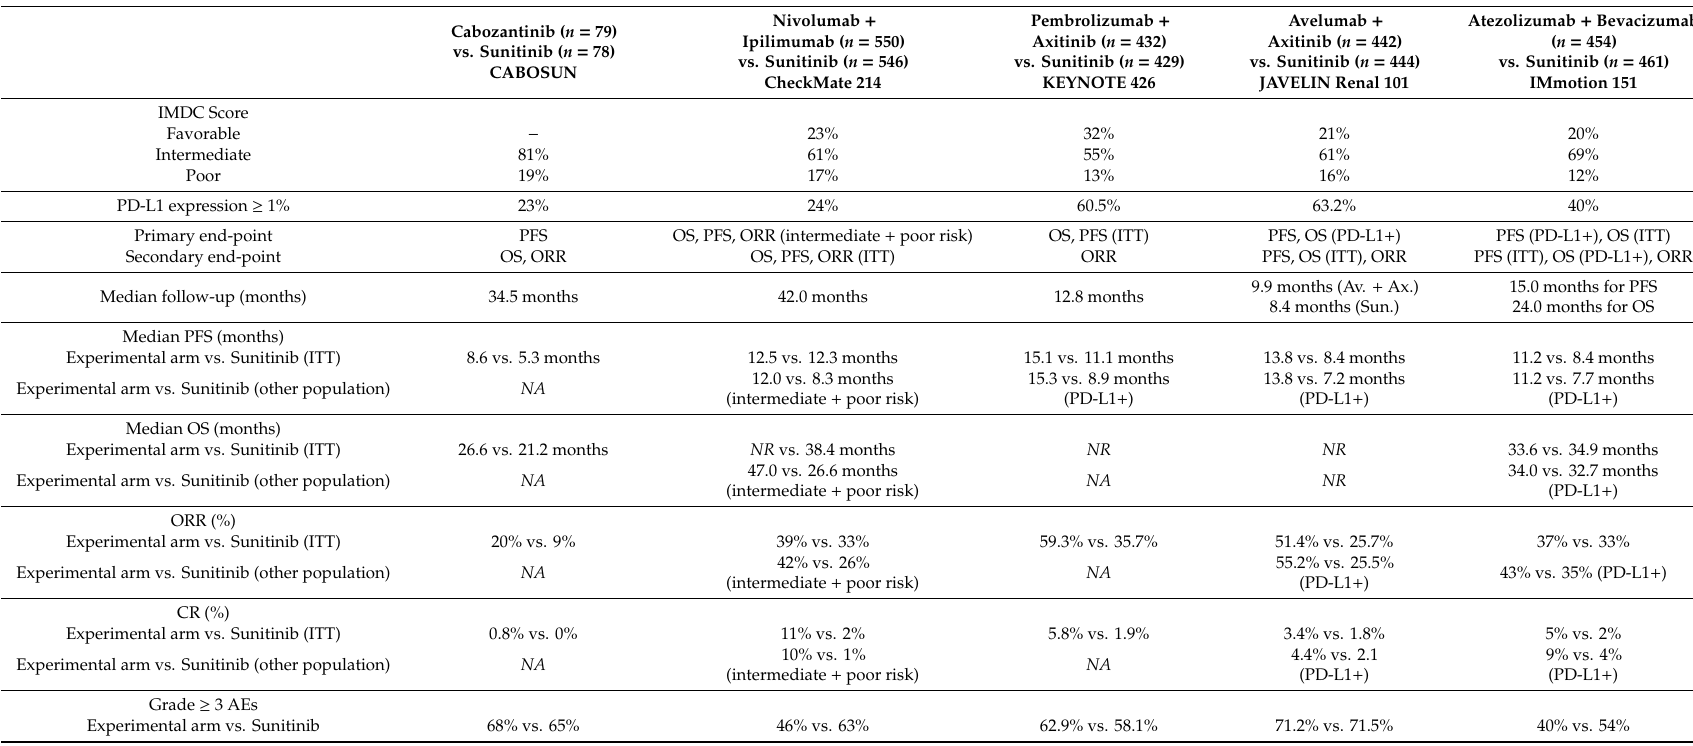
Table 1. Phase II / III trials of novel therapeutic approaches vs. Sunitinib for untreated patients with metastatic renal cell carcinoma. PFS = progression free survival; OS = overall survival; ORR = overall response rate; CR = complete response; AE = adverse events; NA = not available; NR = not reached